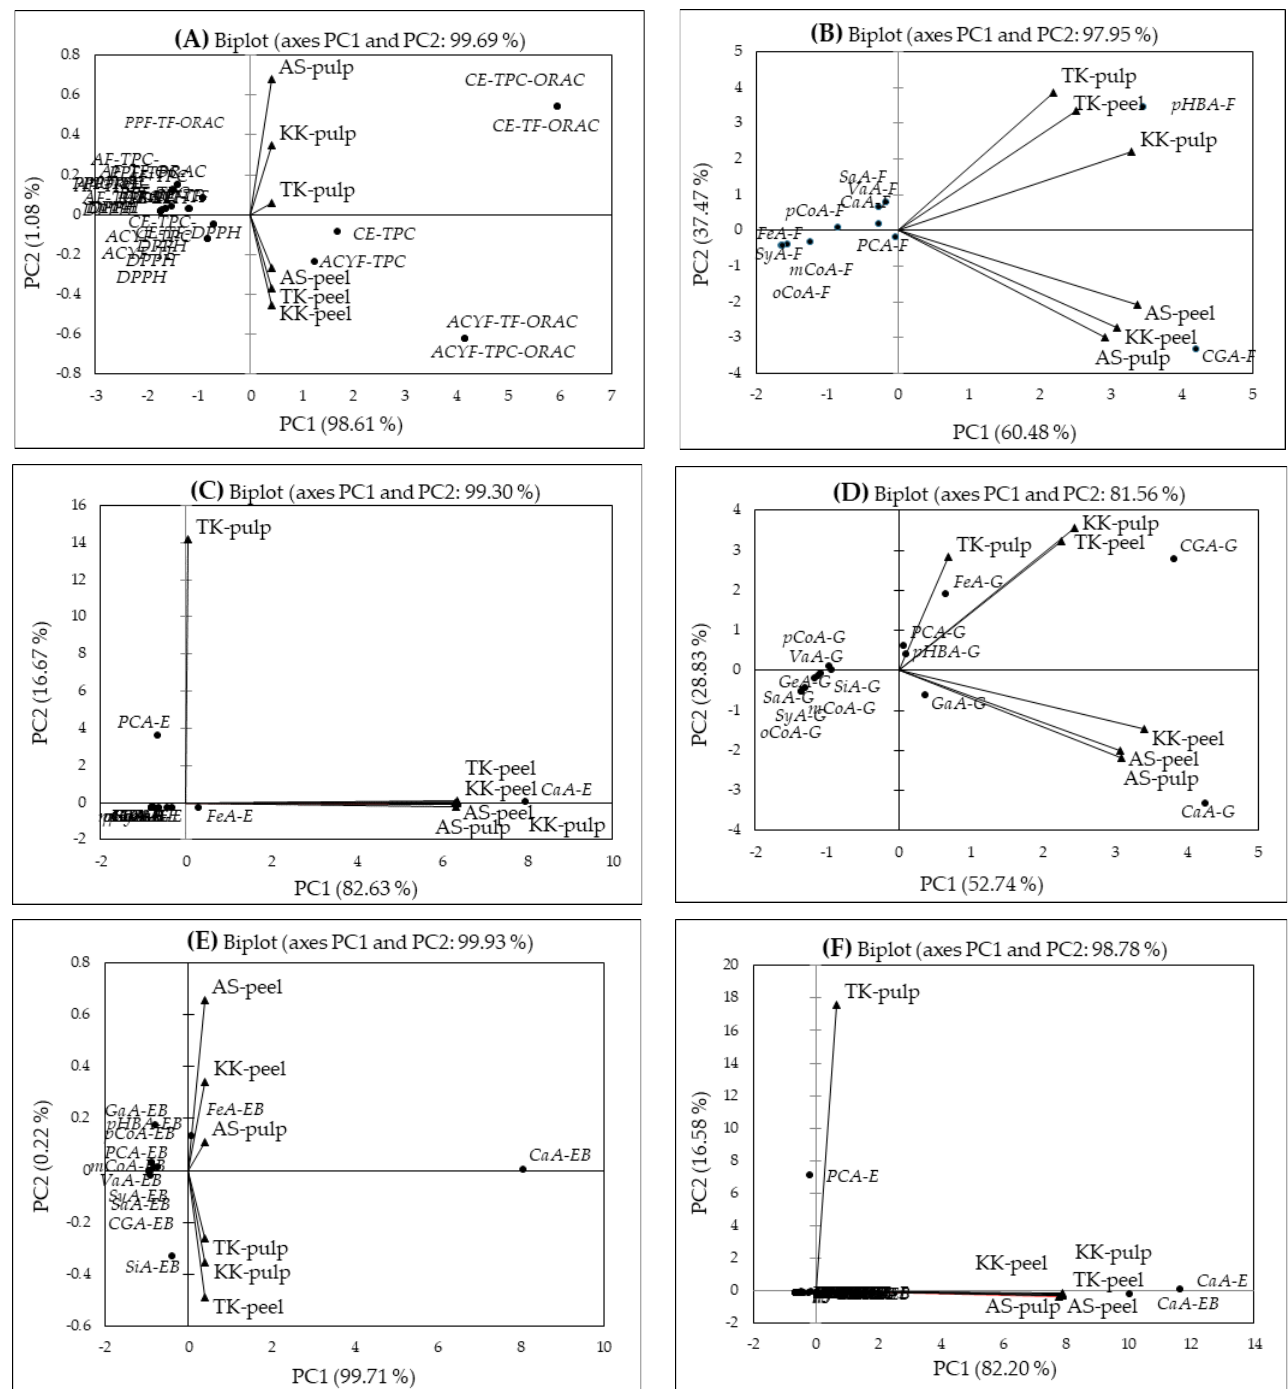
Figure 3. Biplot of the principal component analysis (PCA) of the peel and pulp in the eggplants; total phenolic contents and antioxidant capacity values ( A ); phenolic acids in free ( B ), ester ( C ), glycoside ( D ), and ester-bound ( E ) forms and their combined PCA model ( F ). GaA: gallic acid; PCA: protocatechuic acid; GeA: gentisic acid; p -HBA: p -hydroxybenzoic acid; VaA: vanillic acid; SaA: salicylic acid; SyA: syringic acid; CaA: caffeic acid; p -CoA: p -coumaric acid; SiA: sinapic acid; FeA: ferulic acid; m -CoA: m -coumaric acid; o -CoA: o -coumaric acid; CGA: chlorogenic acid. AS: ‘Aydin Siyahi’ ; KK: ‘Kadife Kemer’ ; TK: ‘Trabzon Kadife’. ▲ : variables; • : observations.